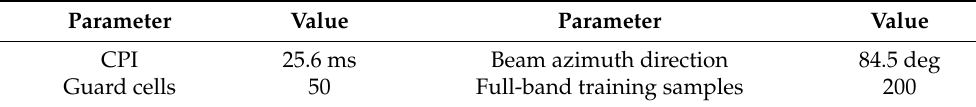
Table 4. Parameters of Sliding Window Processing.